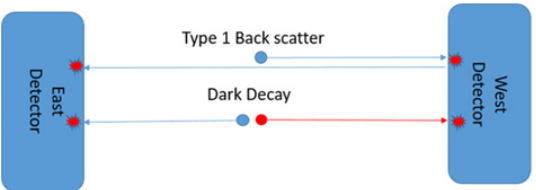
Figure 4. A diagram showing the travel paths of a proposed dark matter decay producing a e + e − pair, compared to a Type 1 backscatter event [17]. Both would register the same electronic signature, but there exists a lower limit on the Type 1 backscatter travel time, which is set by the maximum velocity and the crossing distance between detectors. The e + e − pair has no such